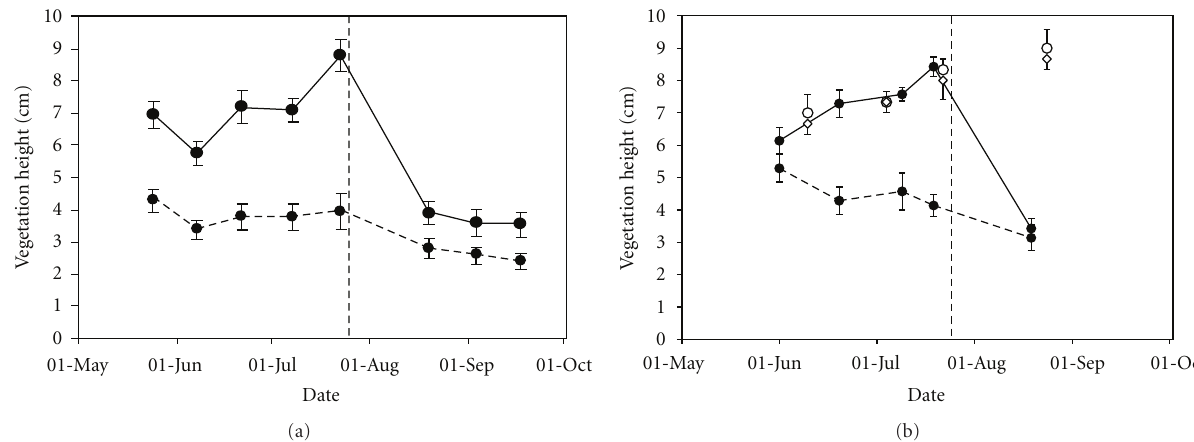
Figure 4: Average vegetation height during the growing season in continuously stocked (dashed line) and late (solid line) grazed areas, in two semi-natural grasslands, Harpsund (a) and Pustn ¨ as (b). Vegetation height inside exclosure cages in Pustn ¨ as is shown by open circles (cages in continuous stocking) and open diamonds (cages in late grazing). Error bars show 1 standard error. Onset of late grazing is indicated with a vertical dotted line. N = 20 plots per treatment in Harpsund, 7 in Pustn¨as; 3 exclosure cages per treatment in Pustn¨as. A dry period in early June caused a temporal drop in turgor and therefore also in the measure of vegetation